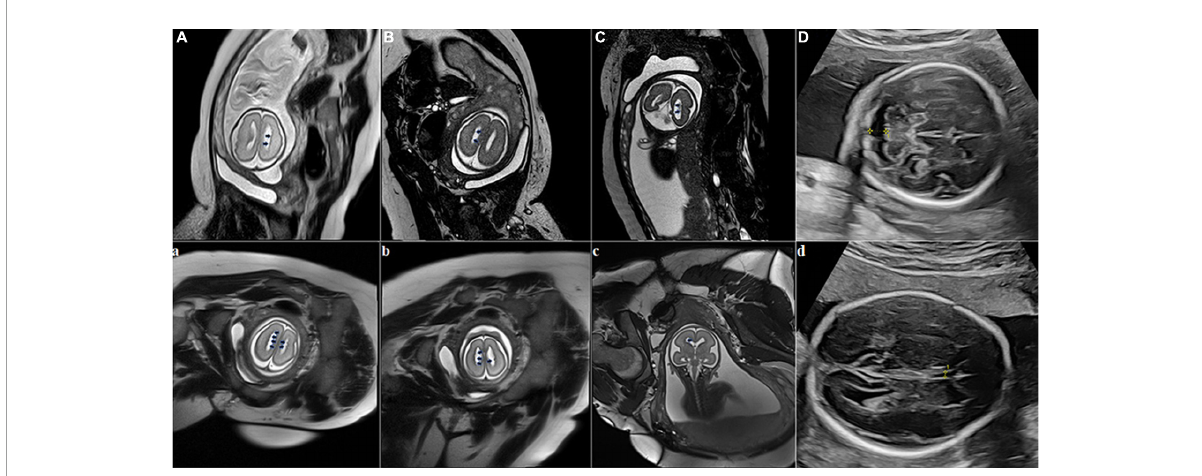
FIGURE1 Fetal brain MRI at two fetuses of the pregnant woman. Fetus 1 (A–D) , scanning at 27 + 1 weeks of gestation with bilateral subependymal heterotopia (SEH). Axial (1A, 1B) and coronal (1C) fetal MRI images show that bilateral ventricles are not dilated, ependyma is irregular, and multiple abnormal signal nodules can be seen. The T2-weighted sequence shows nodules in the ventricular wall similar to gray matter signals (black arrows). Fetal sonogram (D) Axial image, obtained at 26 weeks of gestation through the cerebellar level, shows the widened posterior cranial fossa (yellow measurement arrow); Fetus 2 (a–d) , scanning at 25 + 2 weeks of gestation with bilateral SEH. Axial (1a, 1b) and coronal (1c) T2-weighted sequences at the level of the lateral ventricles show nodules in the ventricular wall similar to gray matter signals (black arrows).